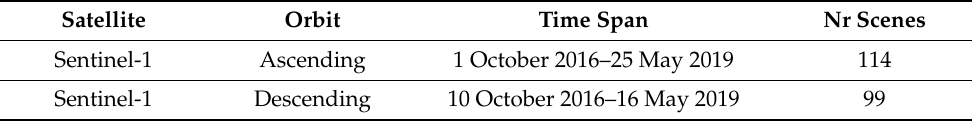
Table 1. Synthetic aperture radar (SAR) imagery analyzed in the present